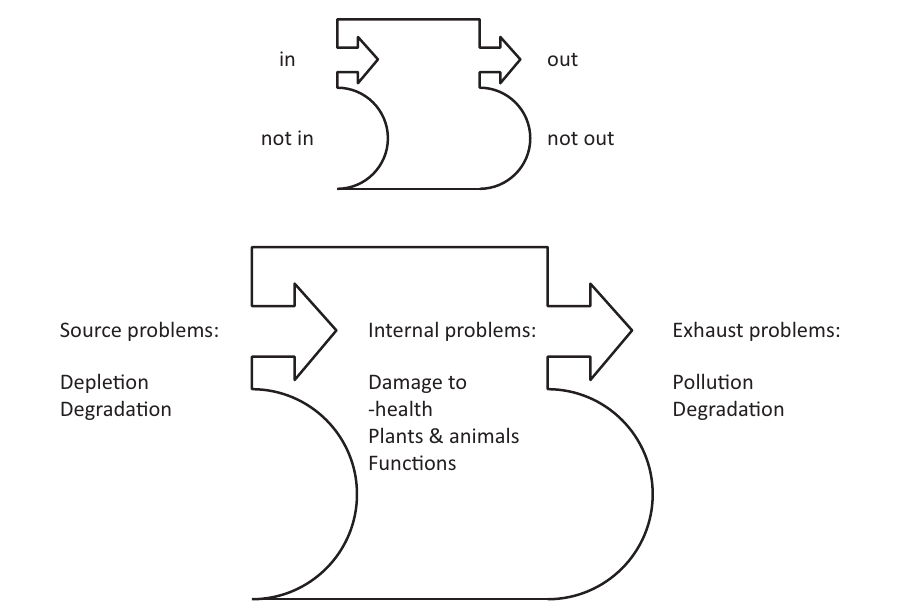
Figure 1. Eco-device model (IN–Not IN; OUT–not OUT). Source: After Van Leeuwen (1981). other level. This way a comprehensive 3D-model of a city could be drawn, and the city seen as an ecosys- tem itself (Tomásek, 1979). The levels Kristinsson deter- mined were the abiotic, biotic, urban and atmospheric layers (Kristinsson, 2012). Nowadays, more layers could and should be added to this systemic image (Figure 2, right), as demonstrated by van Timmeren and Henriquez (2015). The exchange of flows between more layers will open up the possibilities to close cycles and become a more sustainable urban ecosystem. A direct link can be established here with thinking that takes place around the theme of Smart Cities.